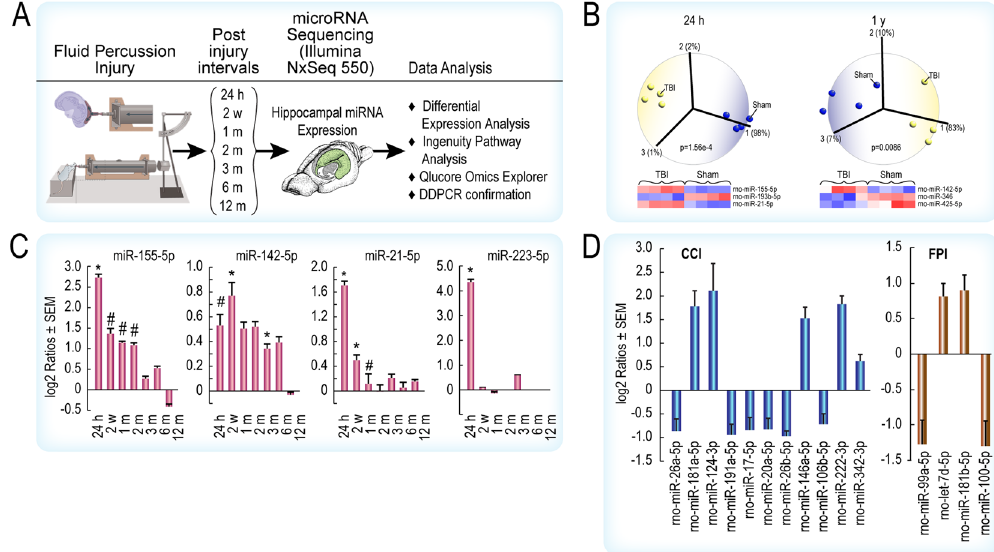
Figure 1. ( A ) Experimental workflow for miRNA-seq analysis of rat hippocampus after fluid percussion injury (FPI). ( B ) Principal component analysis (PCA) revealed miRNAs capable of discriminating between TBI and sham-injured controls at 24 h to 1 y post FPI. ( C ) Analysis of miRNA-seq data in EdgeR and DESeq2 (using both the Wald test and LRT [Likelihood-ratio test] in each) identified four miRNAs that were significantly different compared to sham injured controls in at least one post-injury interval. The * denotes significant [FDR < 0.05] differential expression in both Wald and LRT tests and #denotes significant [FDR < 0.05] differential expression per Wald or LRT test. ( D ) Differentially expressed rat serum miRNAs that are significant compared to sham- injured rats by PCR array analysis after FPI or CCI. Data are displayed graphically as the log2 ratio ± SEM along the y-axis and miRNAs are listed along the x-axis. Data were analyzed through the use of IPA (QIAGEN Inc., https://www.qiagenbioinformatics.com/products/ingenuitypathway-analysis) and Qlucore Omics